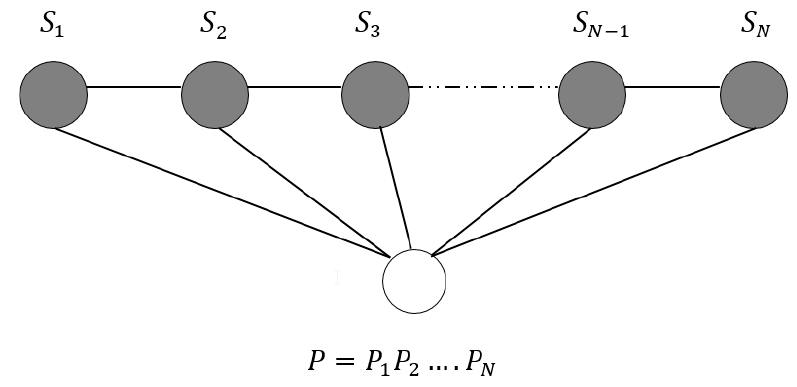
Figure 5. General graphical structure of a linear-chain CRF model.